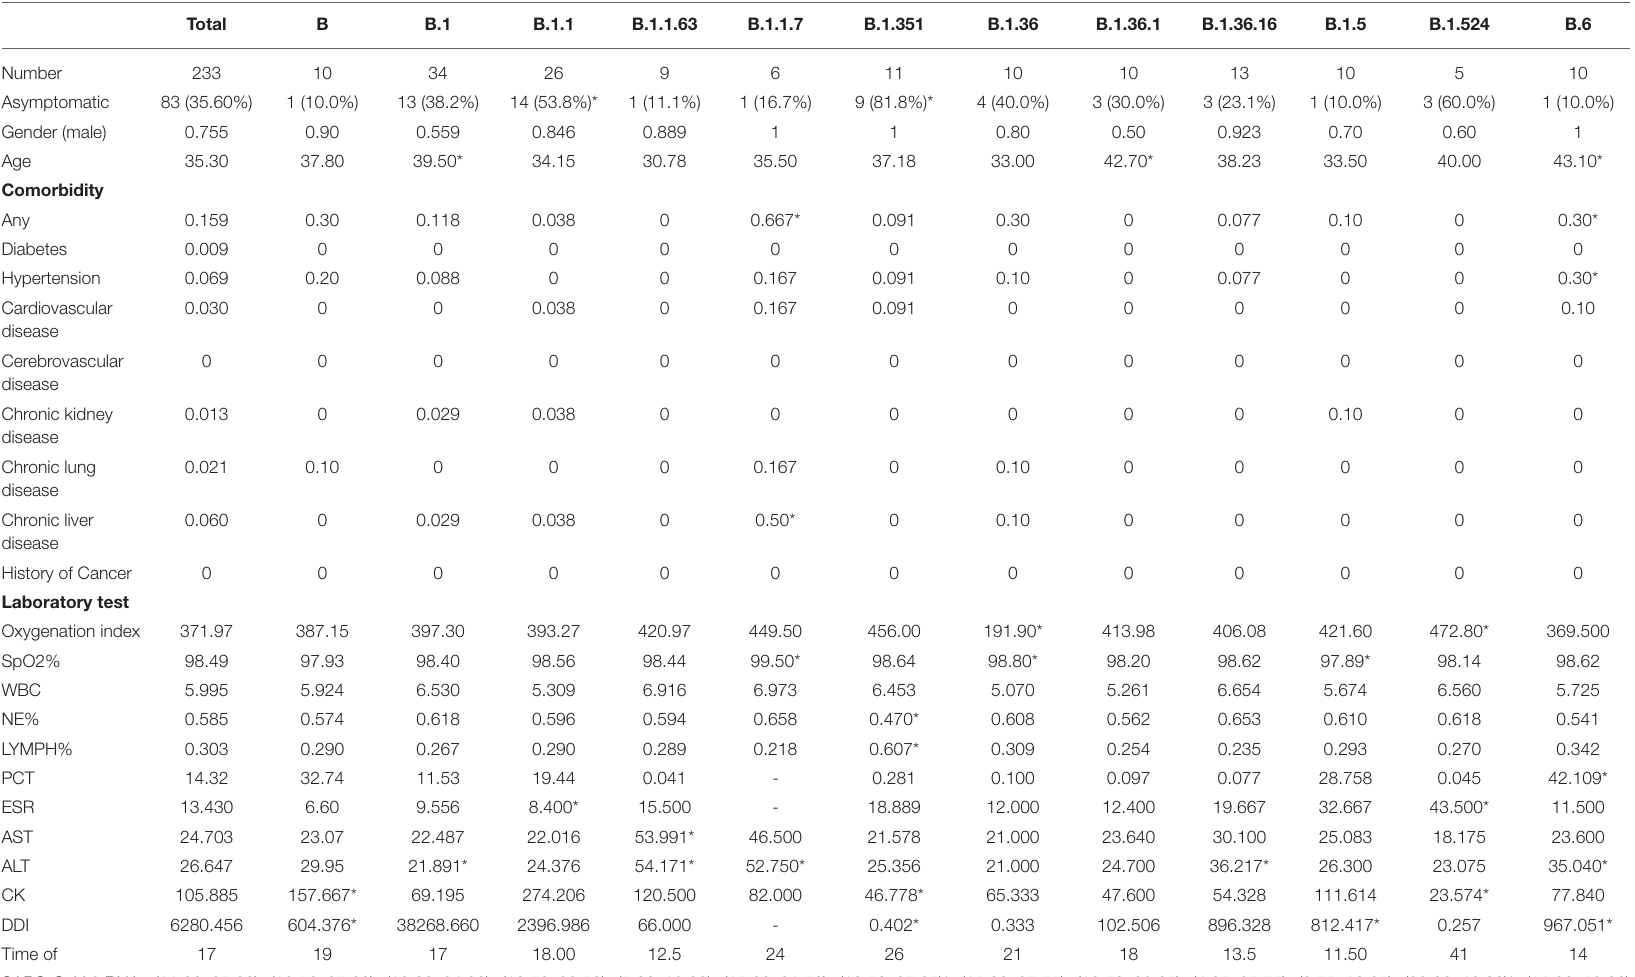
TABLE 2 | Clinical characteristics and time of SARS-CoV-2 RNA turning negative in total and variants infected patients ( n ≥